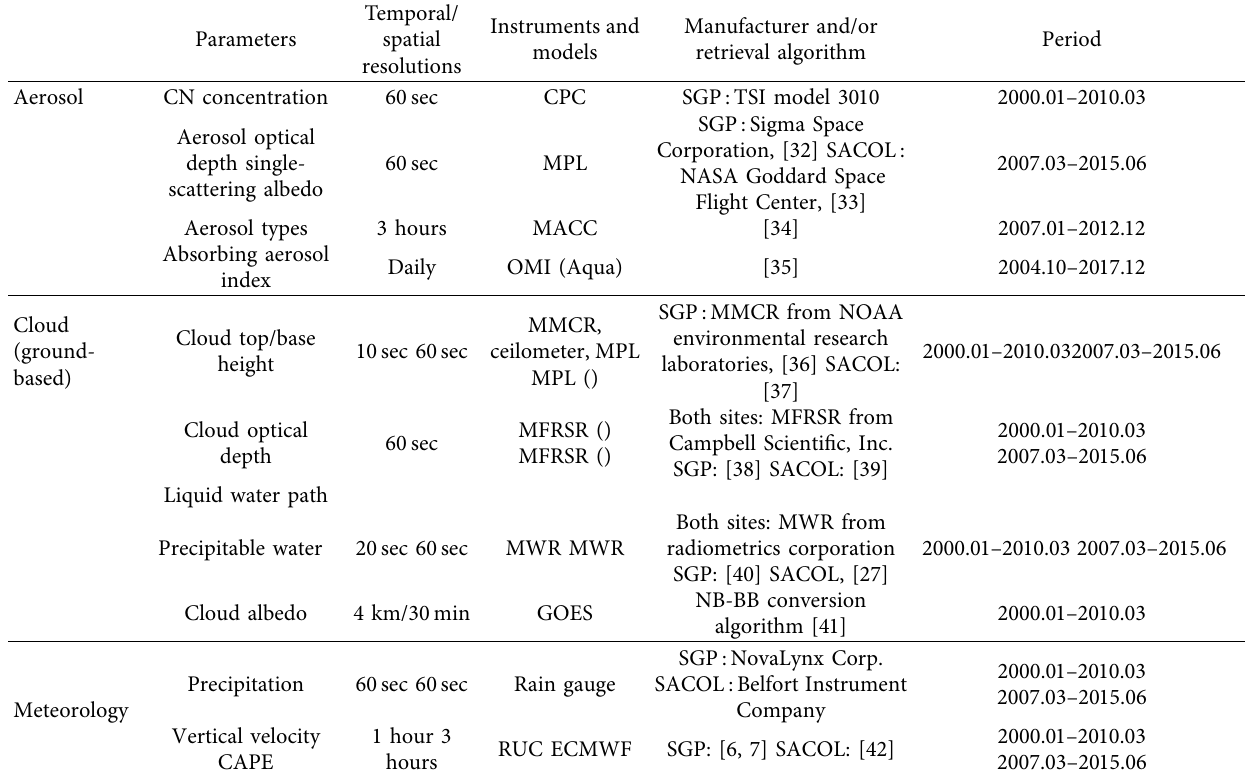
Table 1: Description of data used in the study.